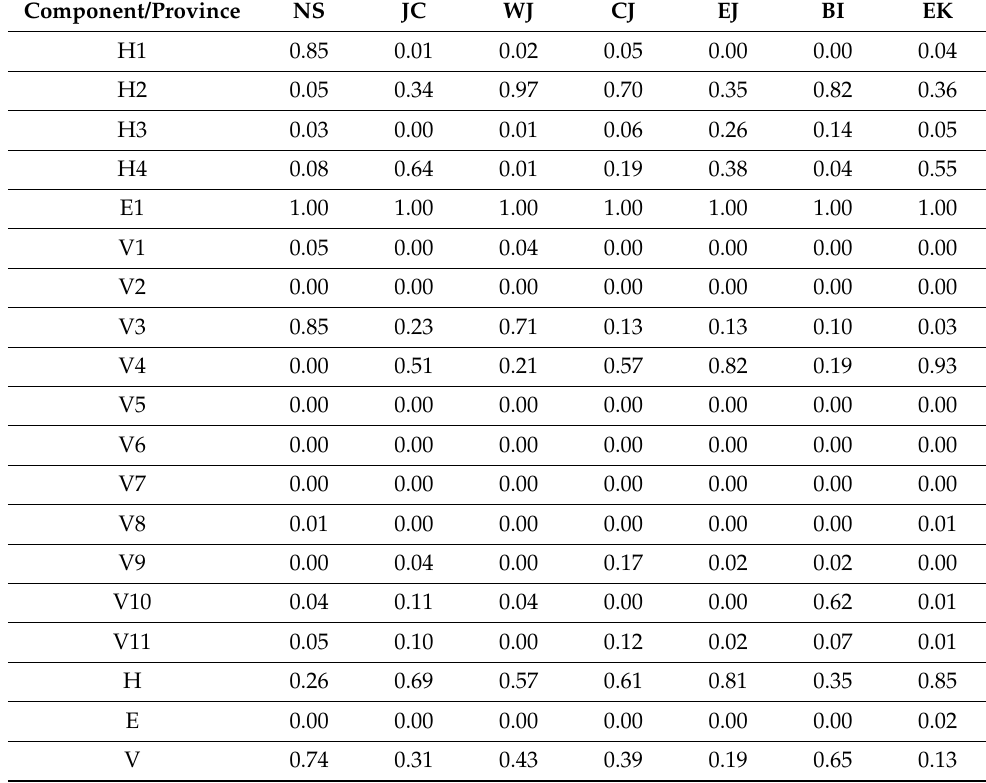
Table A3. Weighted value for each risk